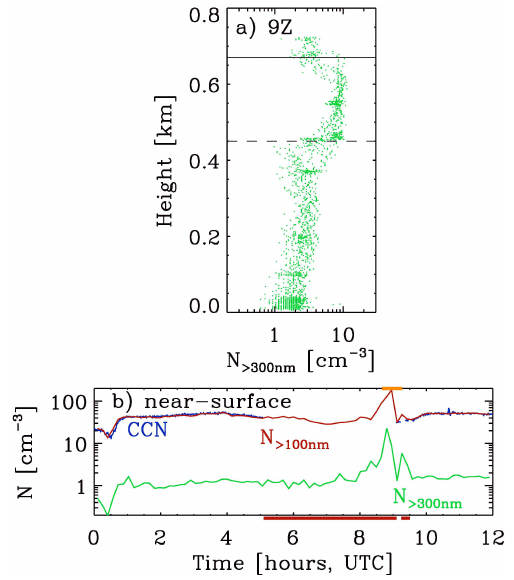
Fig. 5. Near-surface and helicopter aerosol measurements on 28 Au- gust 2008 (Case #1), including (a) helicopter profile of aerosol con- centration for particles larger than 300nm taken at about 9Z, and (b) concentrations of CCN (blue), aerosols larger than 100nm (red) and aerosols larger than 300nm (green) measured onboard Oden . In (a) , the solid and dashed lines are the cloud base and mixed-layer base heights determined by remote sensors at the time, respectively. Red bars on the lower axis of (b) indicate questionable data due to contamination, while the orange bar on the top axis shows the time of the helicopter profile.